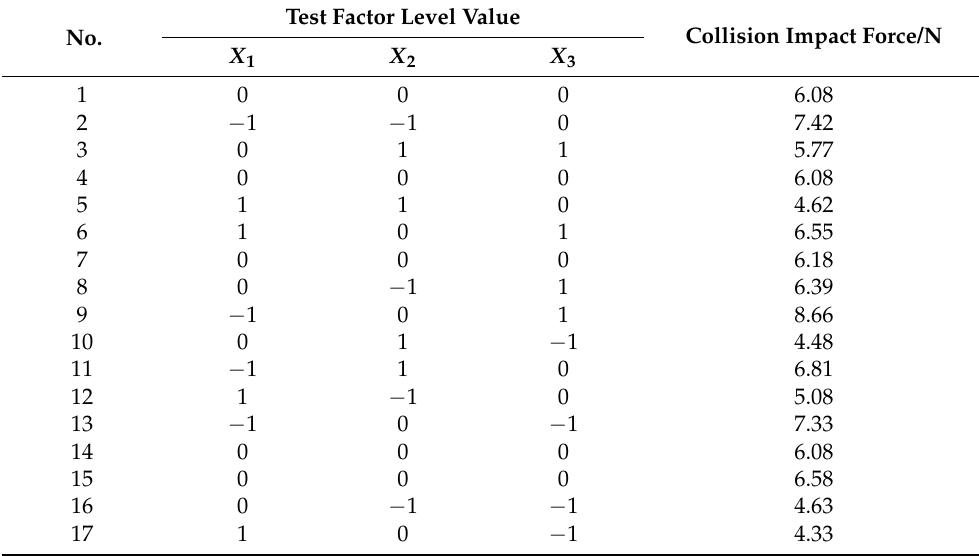
Table 3. Box ‒ Behnken test design and results. Table 3. Box-Behnken test design and